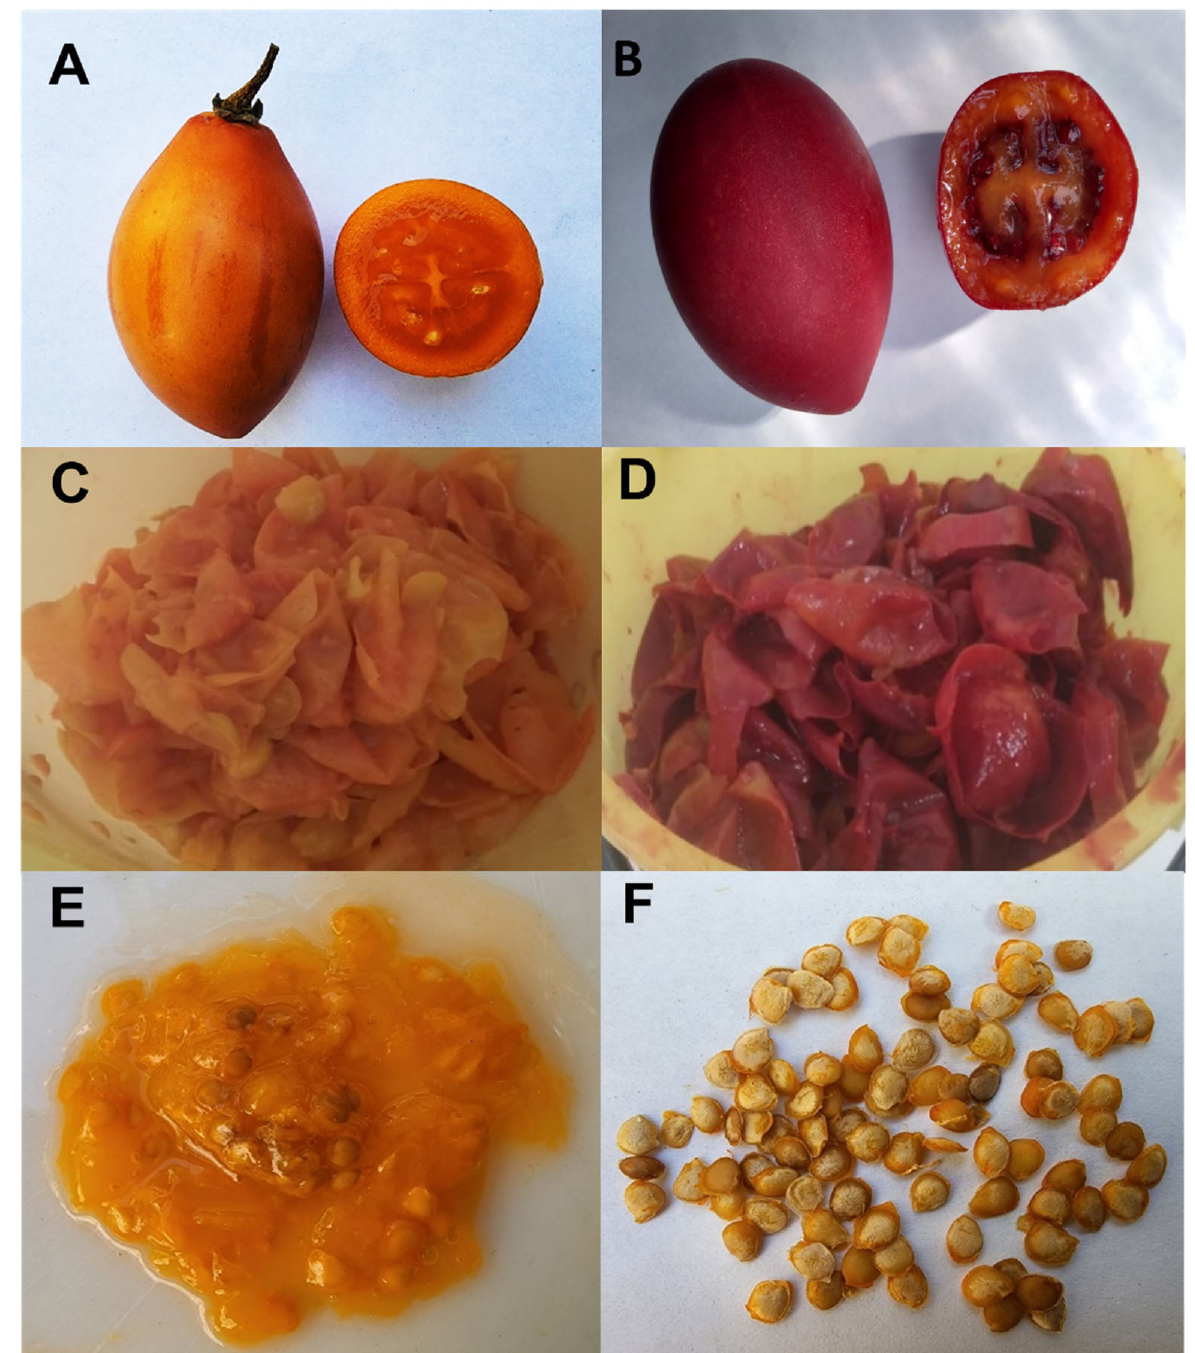
Figure 2. Pictures of ( A ) Solanum betaceum orange fruits; ( B ) S. betaceum red fruits; ( C ) peel of orange fruits; ( D ) peel of red fruits; ( E ) seed ‐ jelly of orange fruits; ( F ) seeds of orange fruits. The pictures were taken by the authors.